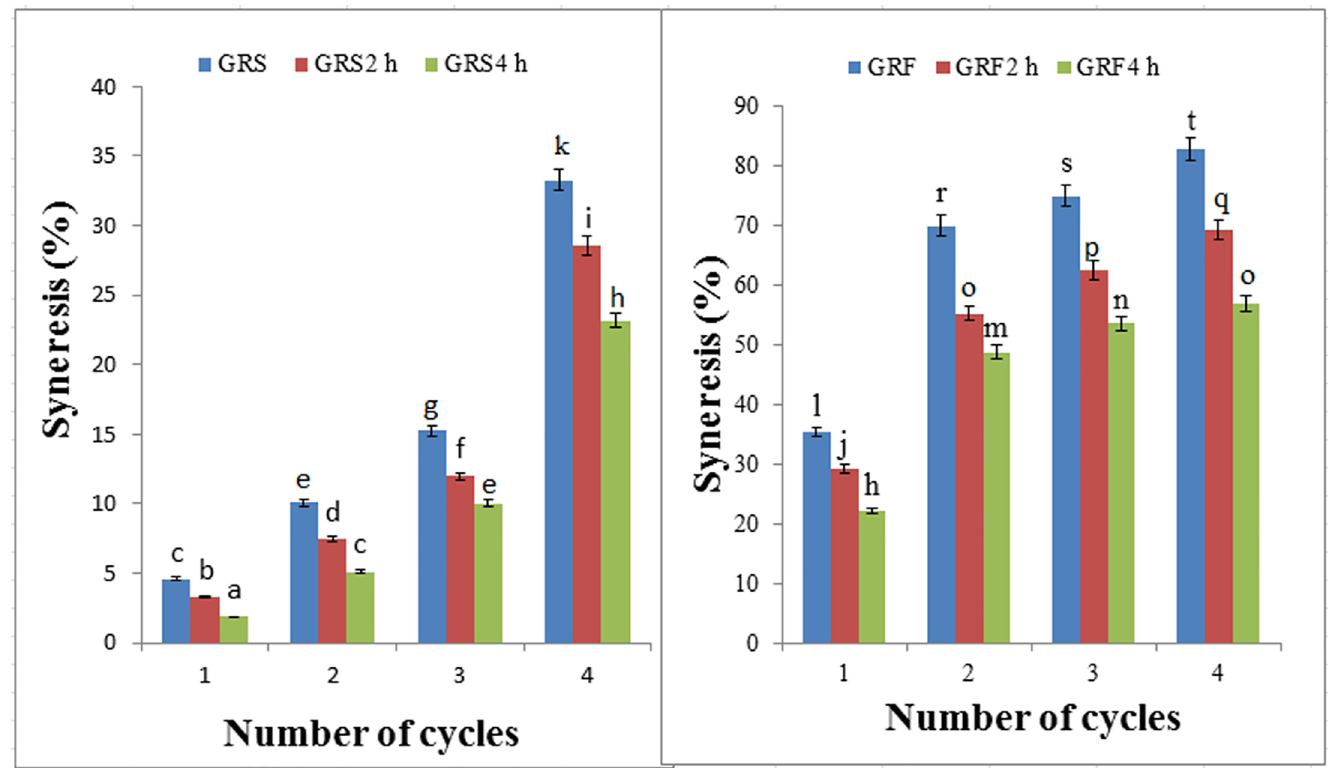
Fig 1. The freeze-thaw stability images of the GRS (A) and GRF (B) before and after dry heating. GRS2 h, 4 h: the glutinous rice starch (GRS) pastes after dry-heat treatment at 130°C for 2, 4 h; GRF2 h, 4 h: the glutinous rice flour (GRF) pastes after dry-heat treatment at 130°C for 2, 4 h. Data represents results from at least three independent experiments and are expressed as mean values ± standard deviations. Different lowercase and capital letters in the same images are significantly different ( p < 0.05).